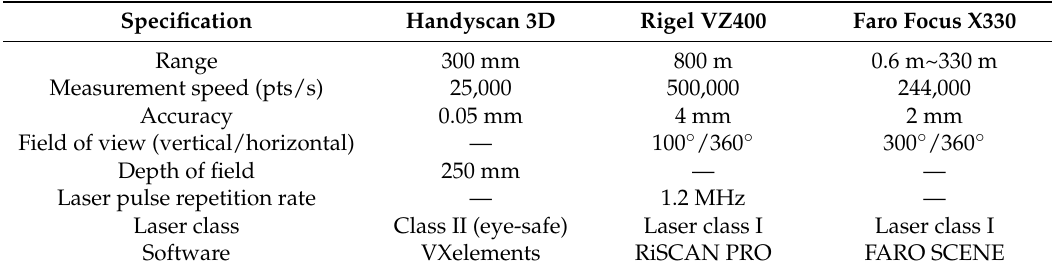
Table 1. Specifications of laser scanners.